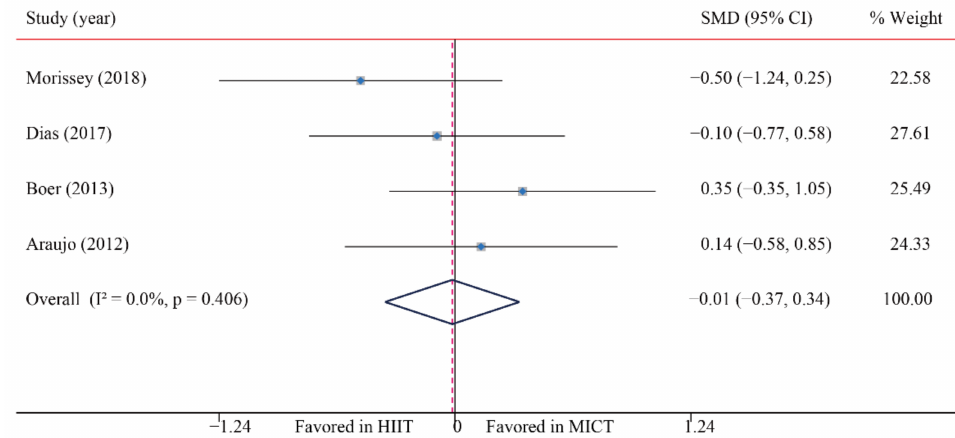
Figure 14. Effect of HIIT versus MICT on blood glucose.